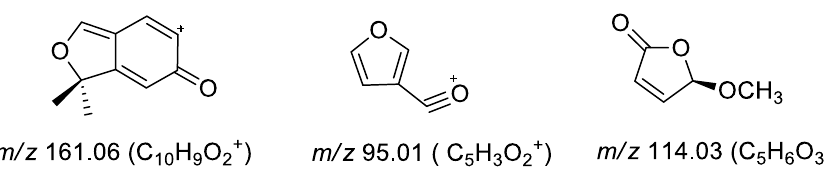
Figure 5. Proposed characteristic fragments’ structures of limonoids.